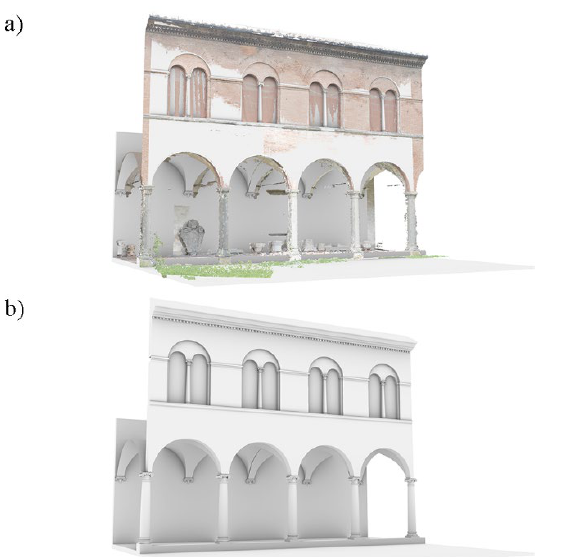
Figure 9. Resulting conceptual model for a portion of the National Museum of San Matteo.